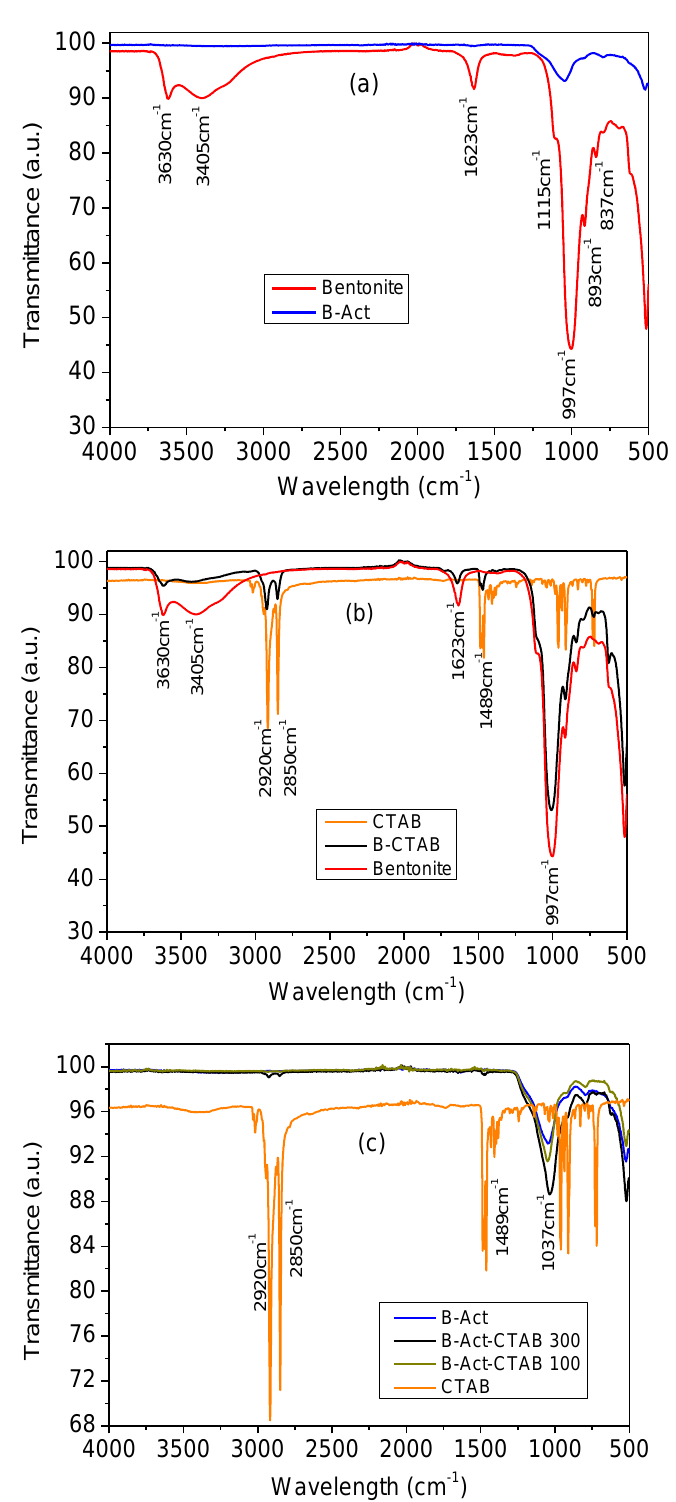
Figure 6. FTIR spectra of ( a ) Bentonite and B-Act, ( b ) Bentonite, CTAB and B-CTAB, and ( c ) B-Act, CTAB, B-Act-CTAB100 and B-Act-CTAB300.